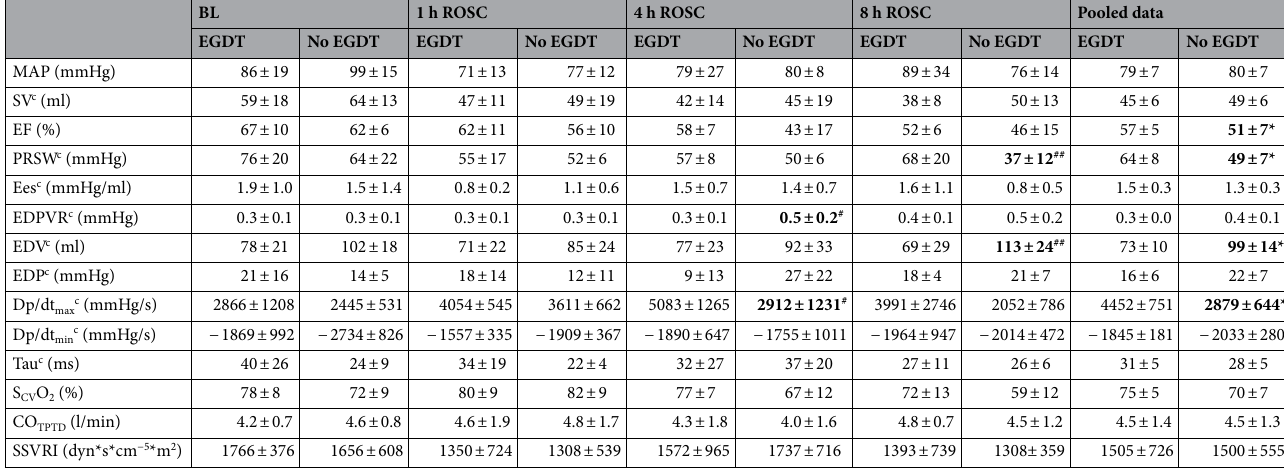
Table 3. Hemodynamic variables and parameters of myocardial function during the study period. Values are presented as mean ± SD. MAP mean arterial pressure, SV stroke volume, EF ejection fraction, PRSW preload recruitable stroke work, Ees end-systolic elastance, EDPVR end-diastolic pressure–volume relation, EDV end-diastolic volume, EDP end-diastolic pressure, Dp/dt max maximal rate of rise of left ventricular pressure, Dp/dt min minimal rate of rise of left ventricular pressure, Tau early diastolic relaxation, S CV O 2 central venous oxygen saturation, CO TPTD cardiac output derived from transpulmonary thermodilution, SVRI systemic vascular resistance index, c variables measured by conductance catheter. # P < 0.05; ## P < 0.01 (repeated measures two-way ANOVA); *P < 0.05 (unpaired t-test or Mann–Whitney-U-Test).